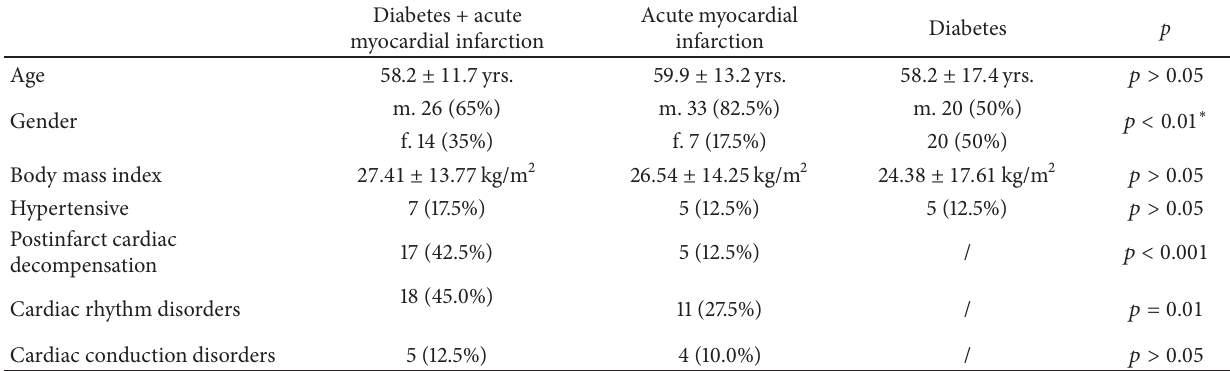
Table 1: Basic demographic and clinical characteristics in three groups of